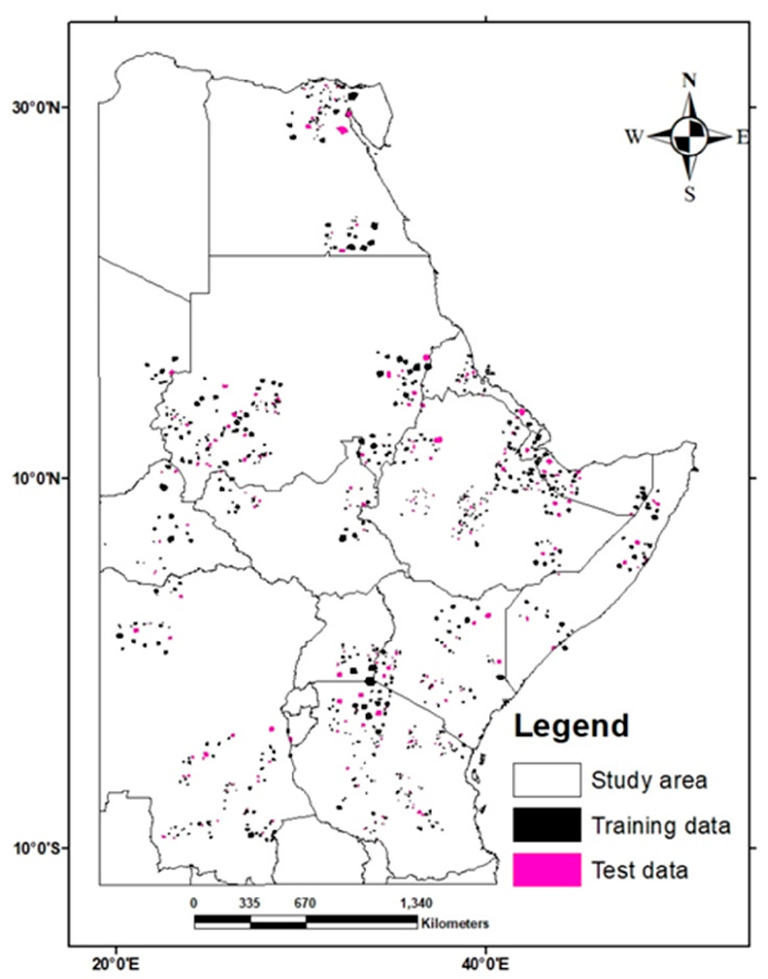
Figure 5. Distribution of training and test data.2.8. Pre-processing of FY-3C 10-day composite data .